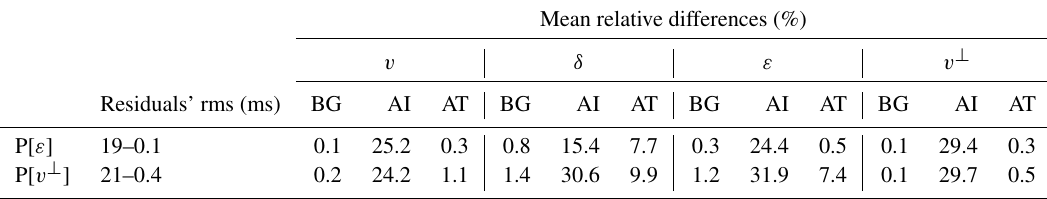
Table 7. Same as Table 4 but for the simultaneous inversion of P[ ε ] and P[ v ⊥ ] using v and ε or v ⊥ target models as initial models (Figs. 9 and 10). Model fits for v and ε or v ⊥ are close to perfect as expected, but even so the recovery of δ is partial at most. Data misfit is smaller than for the original inversions in Figs. 5 and 6. P[ ε ] yields a better result according to all indicators, and as for all previous tests, the recovery of v ⊥ from P[ ε ] is notably better than that of ε from P[ v ⊥ ].